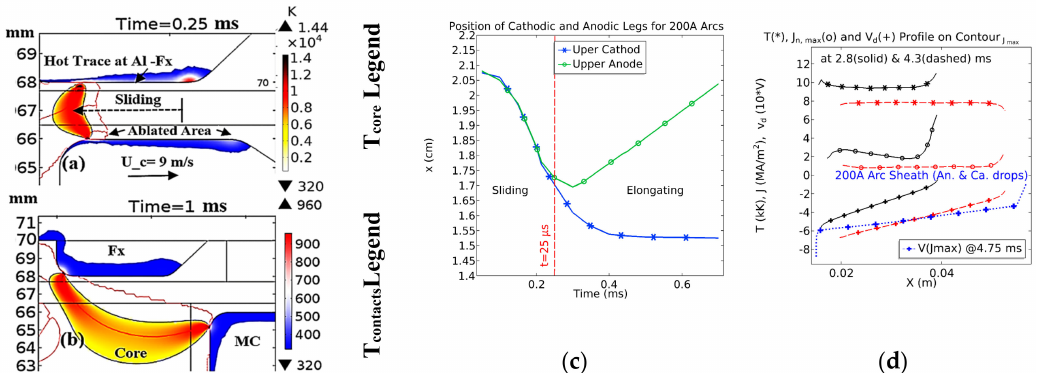
Figure 7. A Core and contacts’ temperatures show ( a ) Arc sliding along the contacts up to 0.25 ms, ( b ) Arc elongating between fixed (Fx) and Moving (MC) contacts at the speed of 9 m / s, ( c ) X-position of arc roots vs. time, and ( d ) Temperature, current density, and voltage profile along the contour of J max